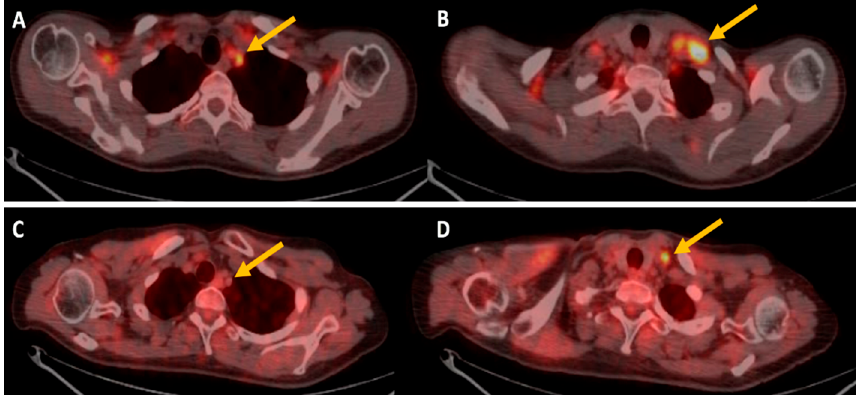
Figure 1. 18 F-FDG PET/CT imaging of a patient treated with bevacizuamb. ( A , B ) are transaxial PET/CT images at baseline that shows high 18 F-FDG uptake in left supraclavicular lymph nodes (yellow arrows), ( C , D ) transaxial PET/CT images after therapy shows reduction of 18 F-FDG uptake (yellow arrows).